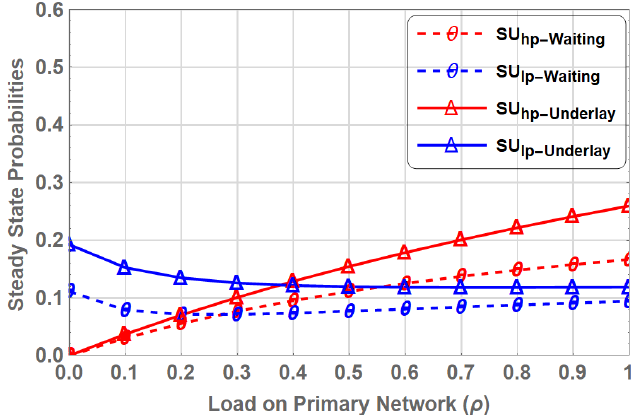
Figure 12. Comparison of interrupted SUs waiting vs. operating in underlay